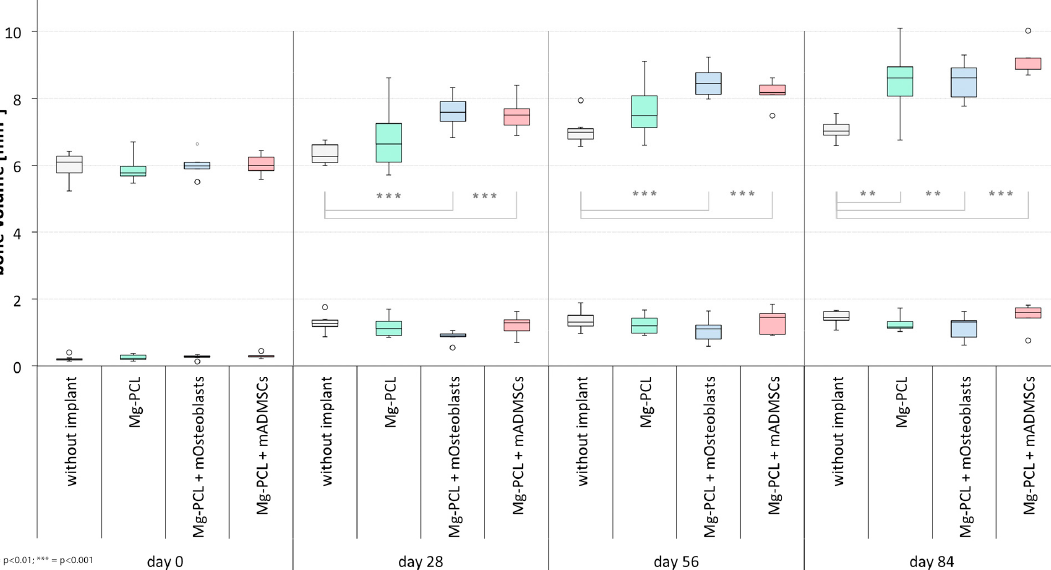
Figure 7. Comparative presentation of the formation of bone volume on the defect treated right side (lower row) and untreated left side (upper row) between the experimental groups at days 0, 28, 56 and 84 (** = p < 0.01; *** = p < 0.001; whiskers = minimal and maximal values; horizontal line = median; circles = outliers).